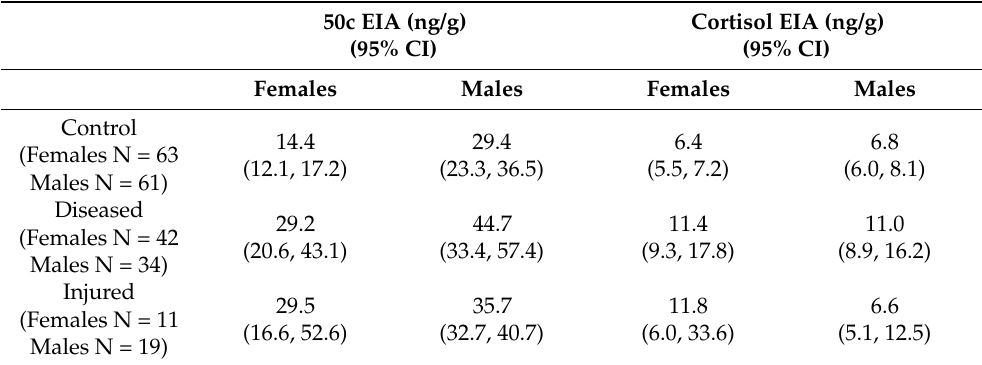
Table 3. Median FCM values (ng/g) (95% CI) measured by 50c and cortisol EIAs (enzyme immunoassays) for females and males in the control, diseased and injured group.